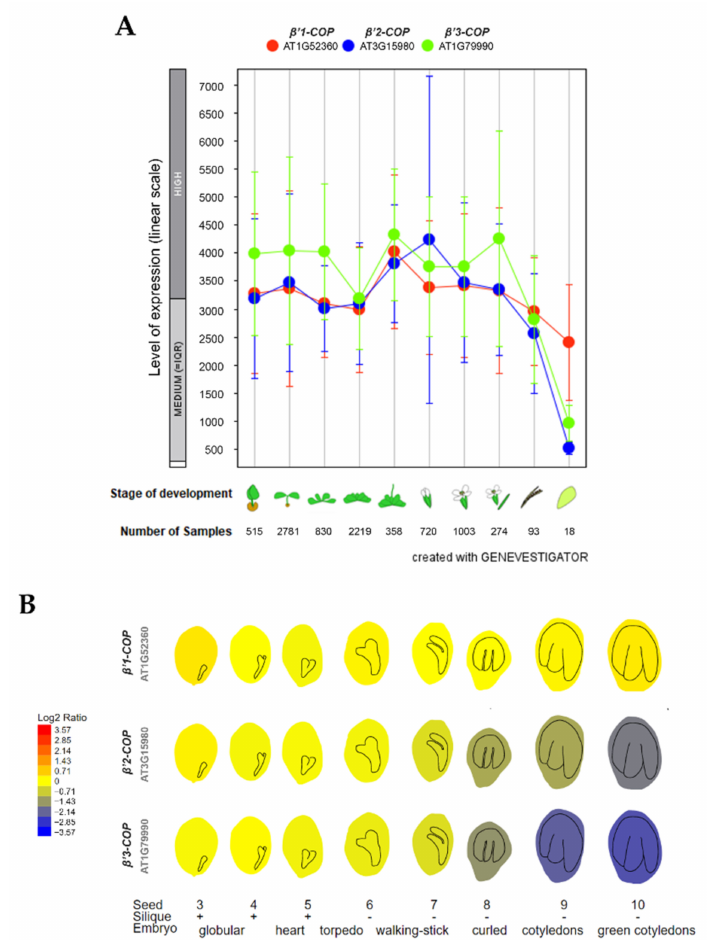
Figure 1. Expression patterns of β ’1-COP , β ’2-COP and β ’3-COP . ( A ) Developmental stage-specific expression pattern in Arabidopsis thaliana . Seedlings, rosette leaves, floral organs and siliques are sequentially marked from left to right. “HIGH”, “MEDIUM” and “LOW” expressions were cal- culated by Afflymetrix Arabidopsis ATH1 genome array. The number of samples indicates RNA gene expression data collected by GENEVESTIGATOR (www.genevestigator.com, accessed on 23 November 2021). ( B ) Seed development expression pattern, from the globular embryo to the green cotyledons seed stage. β ’1-COP shows the highest expression. Data collected and image generated by AtGenExpress eFP (http://bar.utoronto.ca/eplant, accessed on 15 December 2021) [44–46]. Gene expression data generated by the Affymetrix ATH1 array are normalized by the GCOS method, TGT value of 100. Tissues were sampled in triplicate. The legend at the left presents relative expression levels coded by colours (blue = low, red =